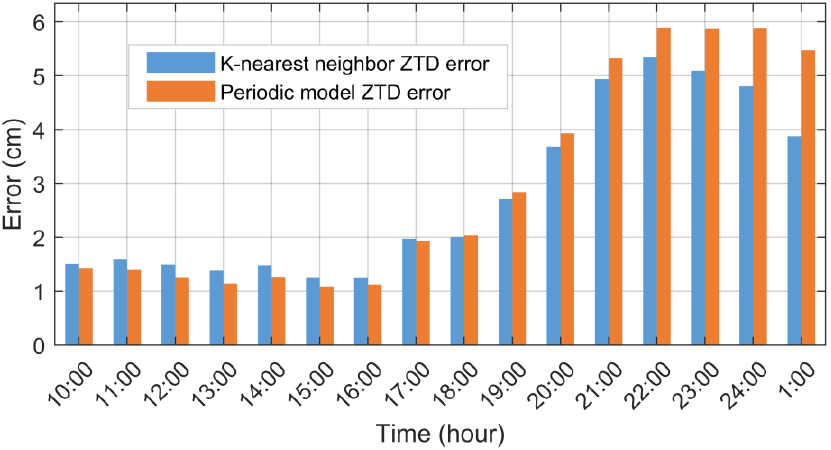
Figure 4. The KNN and periodic model interpolated ZTD error comparison from 10:00 on 3 December 2018 to 1:00 on December 4 at the CQPS station.